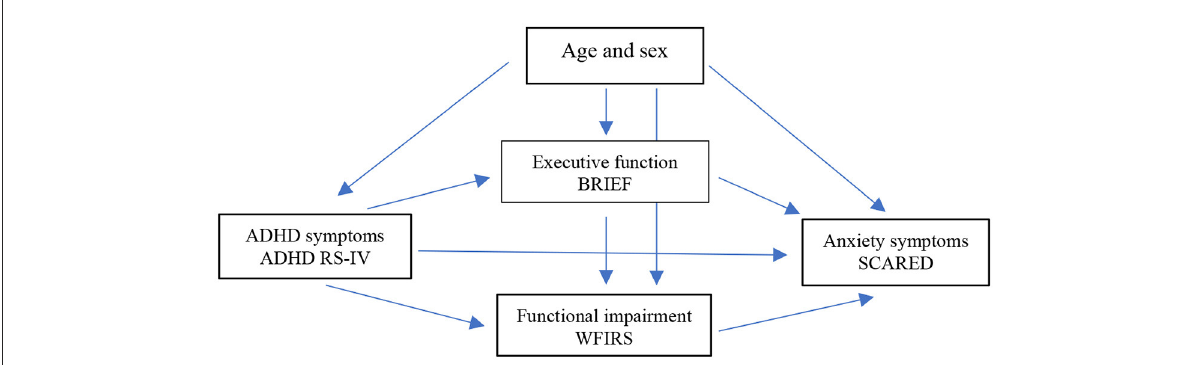
FIGURE1 Hypothetic relationships among ADHD symptoms, functional impairment, executive dysfunction, and anxiety symptoms with the accompanying measurements. Age and sex are potential confounders.